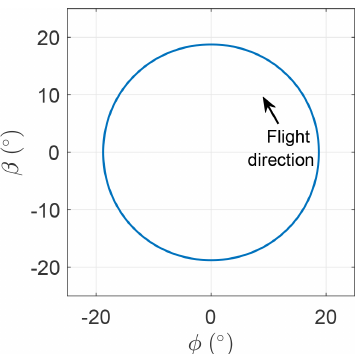
Figure 6. Optimal trajectory.